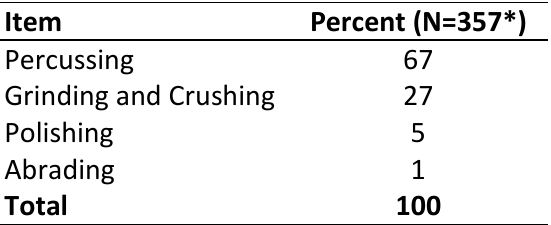
Table 5. Relative frequencies of functional activities represented in the Khirbat en-Nahas 2006 ground stone assemblage. * Ballistic stones, multiple-use tools and ‘other’ objects are not